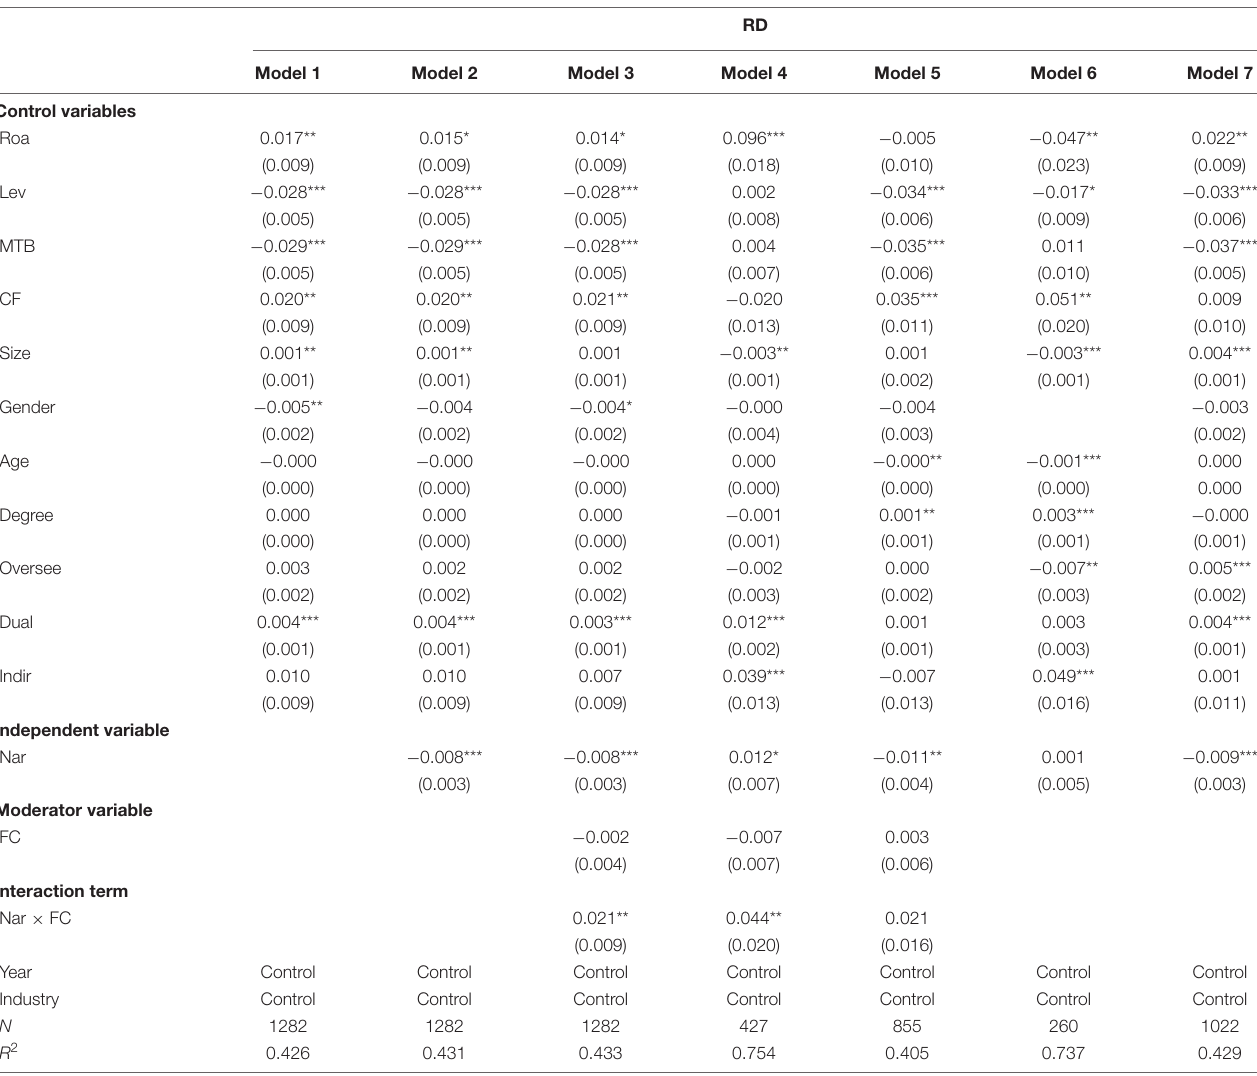
TABLE 4 | Regression analysis